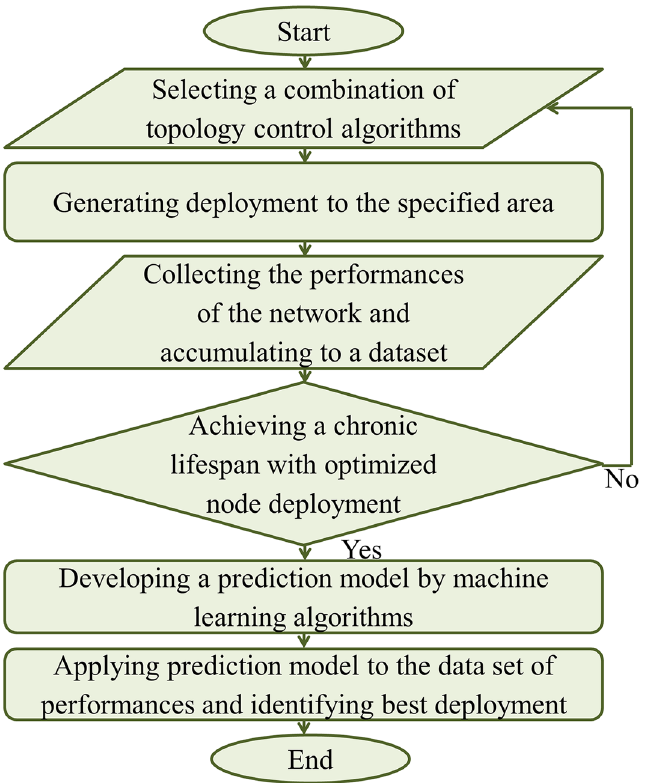
Figure 5. A flowchart of the proposed